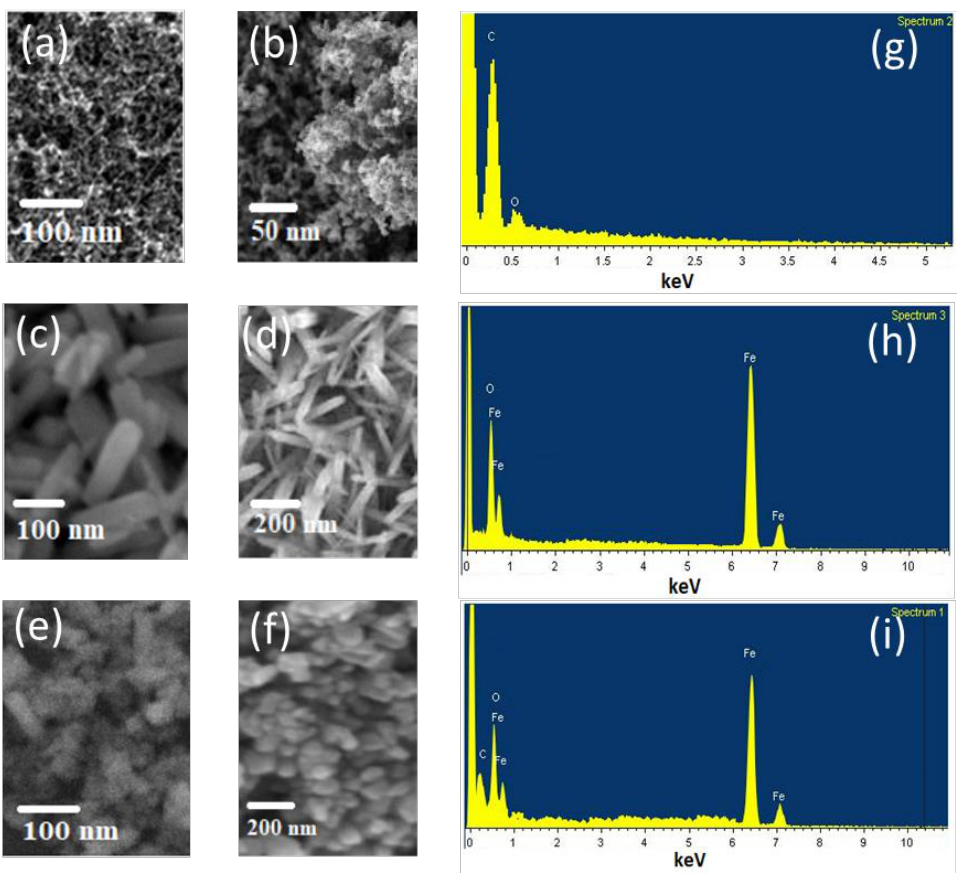
Figure 3. SEM of ( a,b ) carbon, ( c,d ) α -FeOOH and ( e,f ) the FeOOH/C composite, and EDS of ( g ) carbon, ( h ) α -FeOOH and ( i ) the FeOOH/C composite.